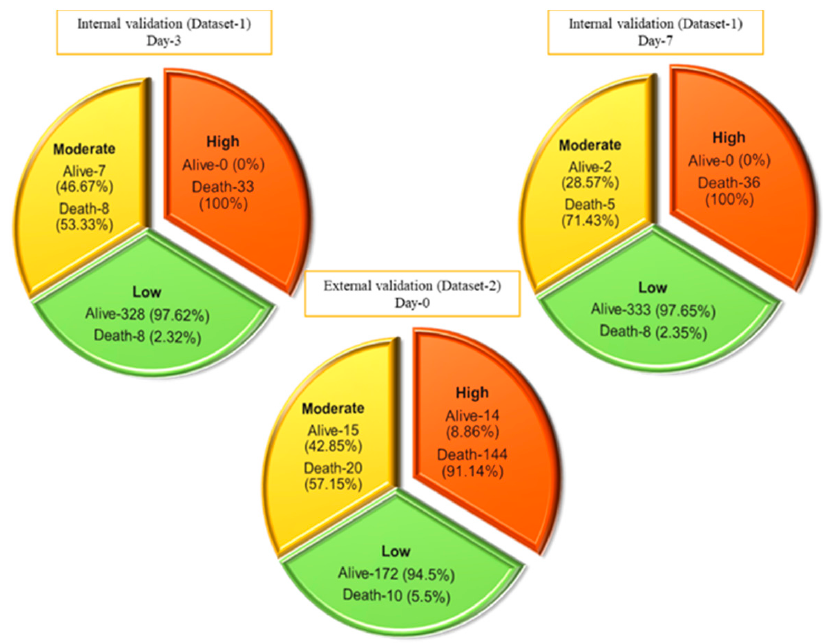
Figure 7. Prediction of internal and external validation with Dataset-1 and Dataset-2 using ALDCC score.